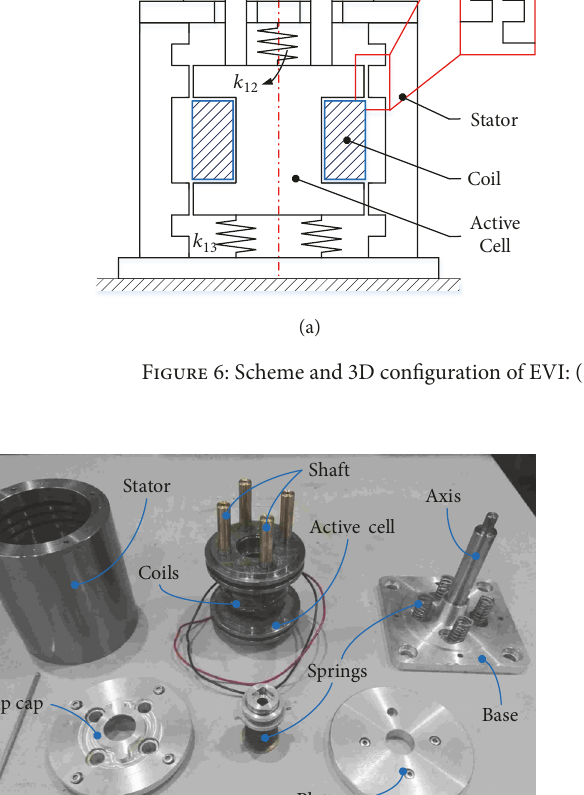
the desired position when no electric power is applied and no additional isolated mass is added. The mechanical coil springs symbolized by 𝑘 11 , placed between the plate and the cylinder body, are only used to balance the additional mass and provide positive vertical stiffness in future